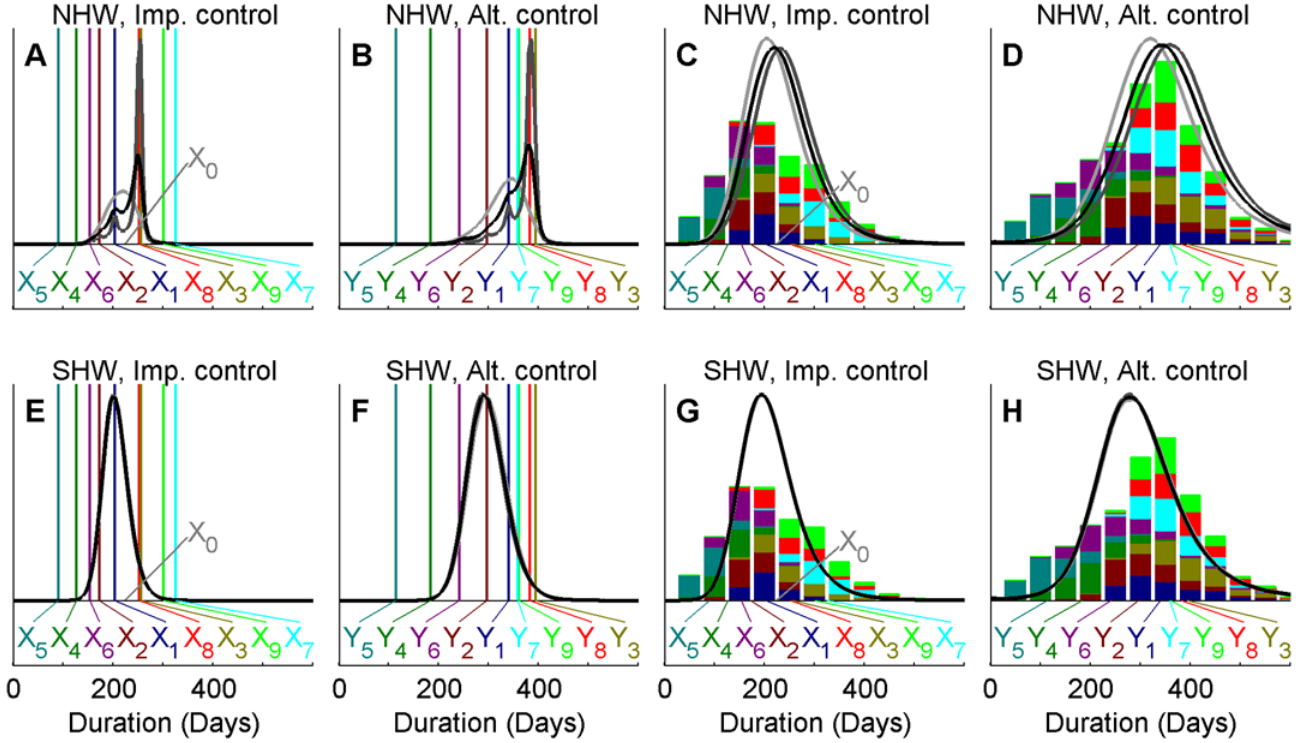
Fig 2. Ensemble prediction for the UK 2001 FMD outbreak duration. Comparing two methods of ensemble prediction of expected outbreak duration under implemented and alternative control actions (panels A, E and B, F, respectively) as well as the corresponding duration of individual outbreaks (panels C, G and D, H, respectively). The observed duration of the UK 2001 FMD outbreak is indicated by X0 while vertical colored lines (panels A, B, E and F) and annotations X1 , X2 ,.., X9 and Y1 , Y2 , ... , Y9 indicate the mean outbreak duration of each projection. The total bar height (panels C, D, G, H) indicate the frequency of simulations across all projections with outbreaks ending within each 50 day interval and colors indicate the contribution of each of the projections. Results are shown for analyses of the large discrepancy ensemble using the NHW method (panels A-D) and the SHW method (panels E-H). Marginal posterior estimates correspond to different priors, with prior parameters a λ = b λ = 0.01 (light gray), a λ = b λ = 0.001 (black) and a λ = b λ = 0.0001 (dark gray) the NHW method (panels A-D) and Aa λ = Ab λ = Ba λ = Bb λ set to 0.01 (light gray), 0.001 (black) and 0.0001 (dark gray) for the SHW method (panels E-H). Note that posterior estimates are very similar for the latter, making the lines